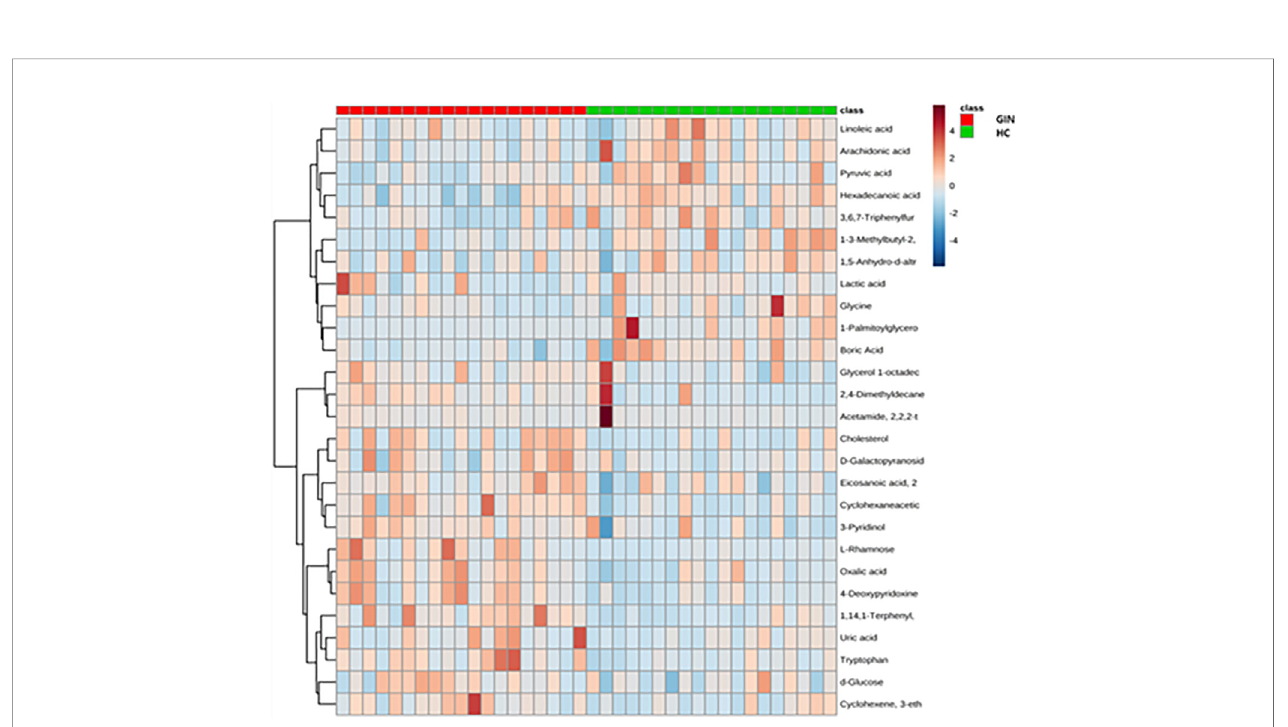
FIGURE 7 | Cluster analysis graph of differential metabolites between gingivitis group (red) and healthy control group